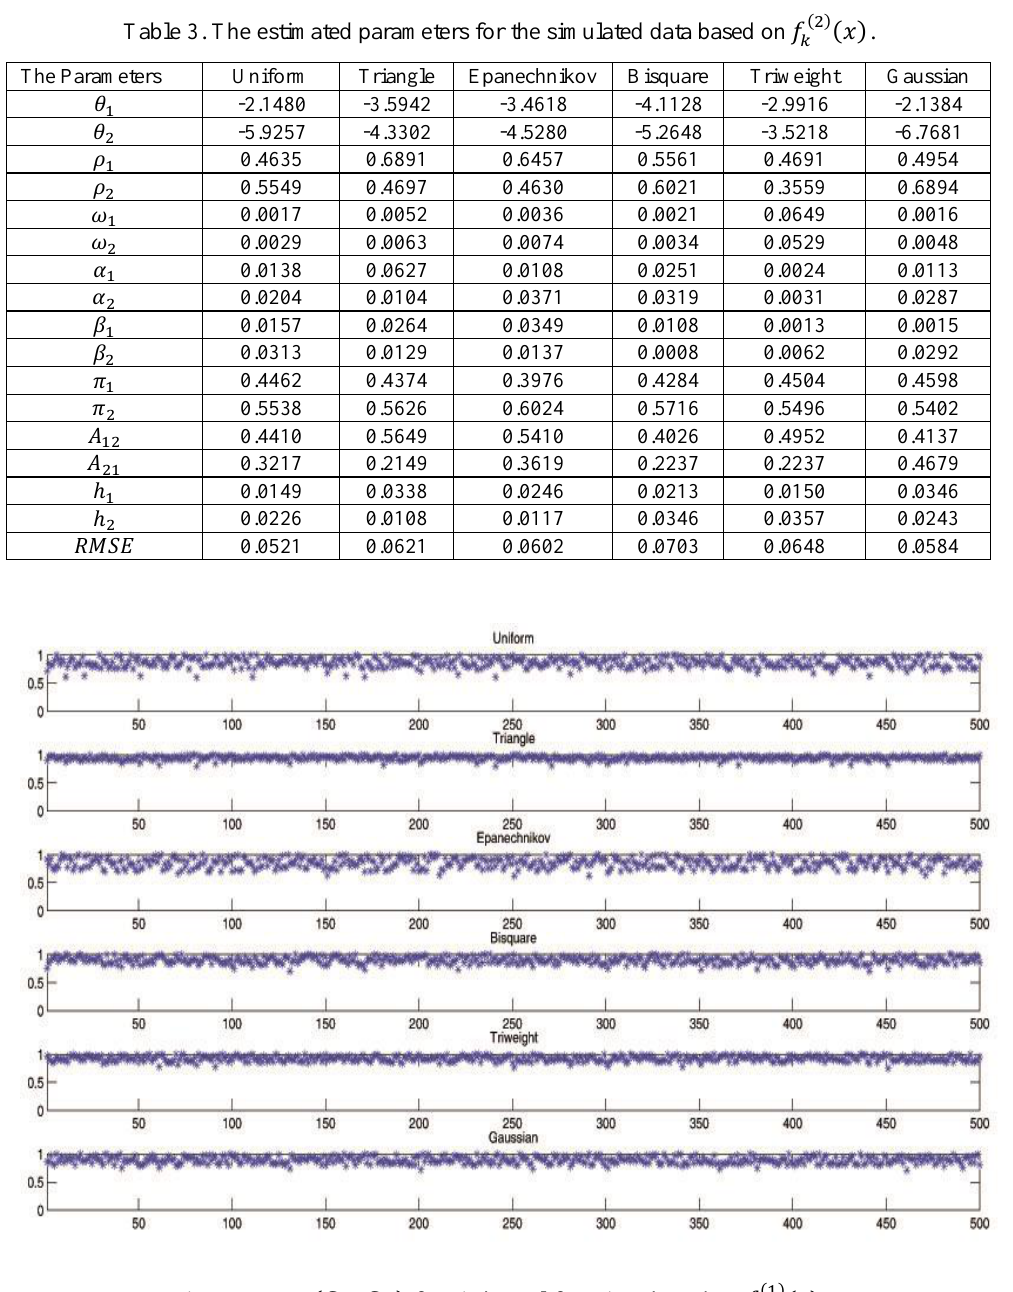
Figure 3. Max ( ) for six kernel functions based on ( ) ( )